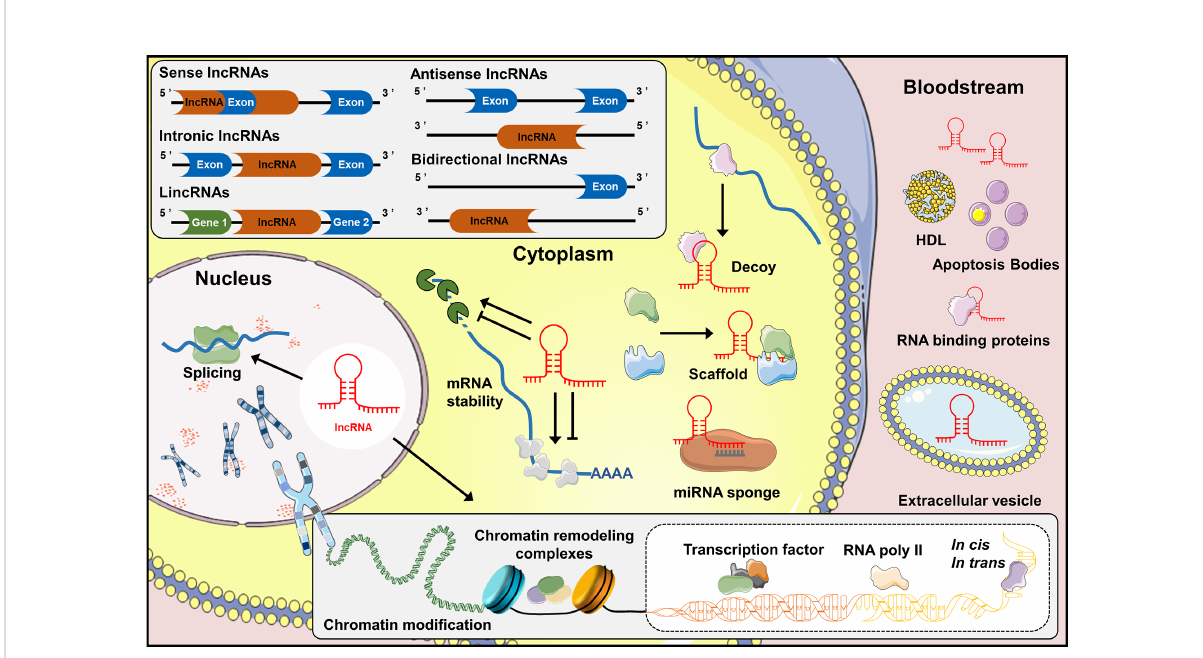
FIGURE 1 Biogenesis and function of lncRNAs. Classi fi cation of lncRNAs into fi ve classes: sense lncRNAs, intronic lncRNAs, lincRNAs, antisense lncRNAs and bidirectional lncRNAs, based upon their genomic locations and transcription. LncRNAs regulate the expression of genes in the cytoplasm by interacting directly with microRNAs (miRNAs) or proteins, and stabilizing mRNA transcripts. Noncoding transcripts in the nucleus are known to regulate gene expression at the level of chromatin modi fi cation, transcription and post-transcriptional processing. In addition, lncRNAs are considered as biomarkers or participant in tissue crosstalk by entering the bloodstream directly, or bound to carrier proteins, even incorporated into extracellular vesicles which can be further released into